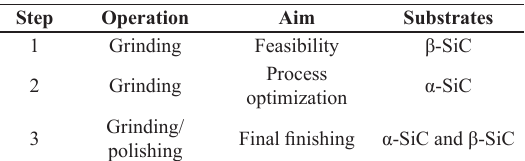
Table 1. Operating sequence for experimental processing of